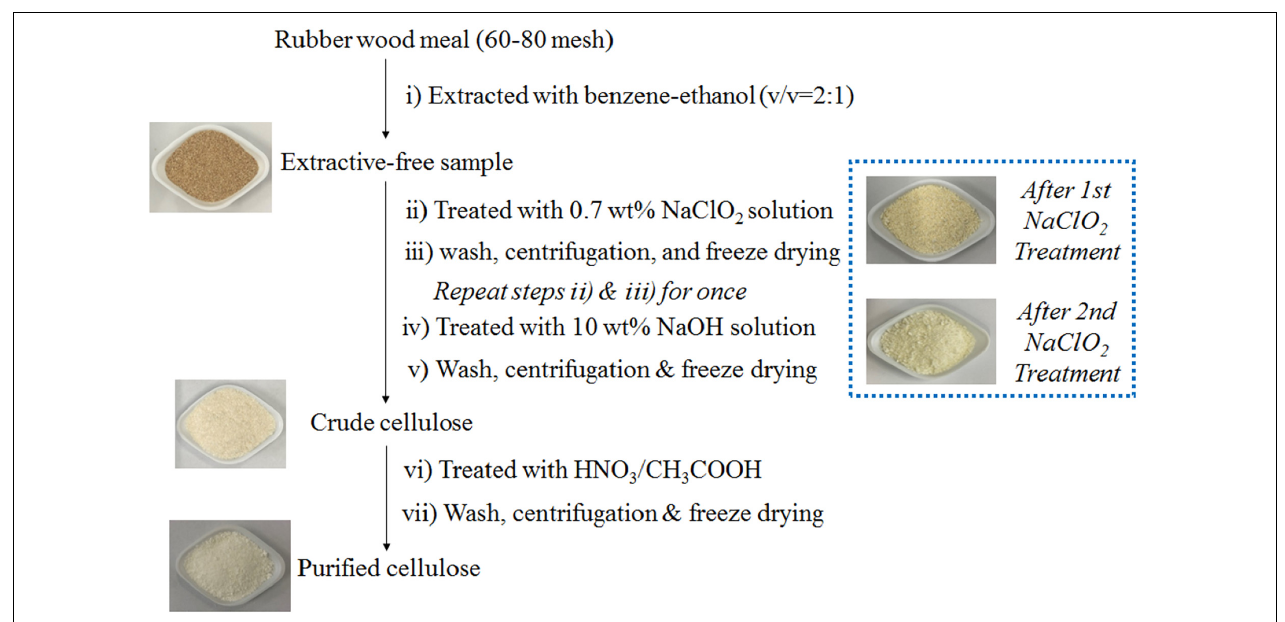
FIGURE 1 | The technical flowchart of separation and purification of rubber wood